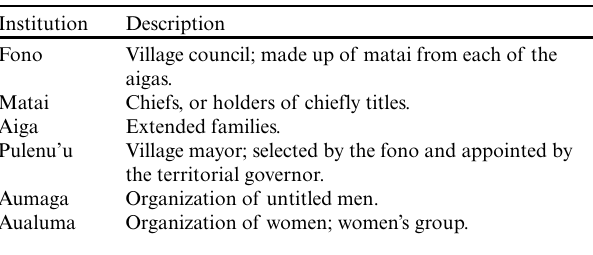
Table 1 . Indigenous institutions in fa’a